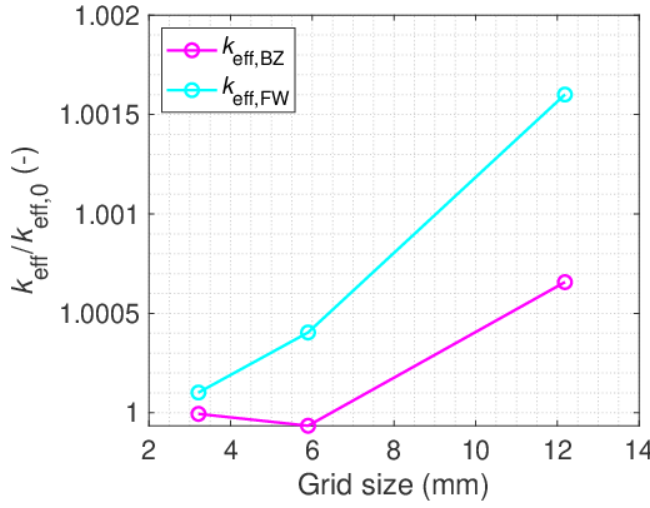
Table 1. Results of the grid independence study. 0.